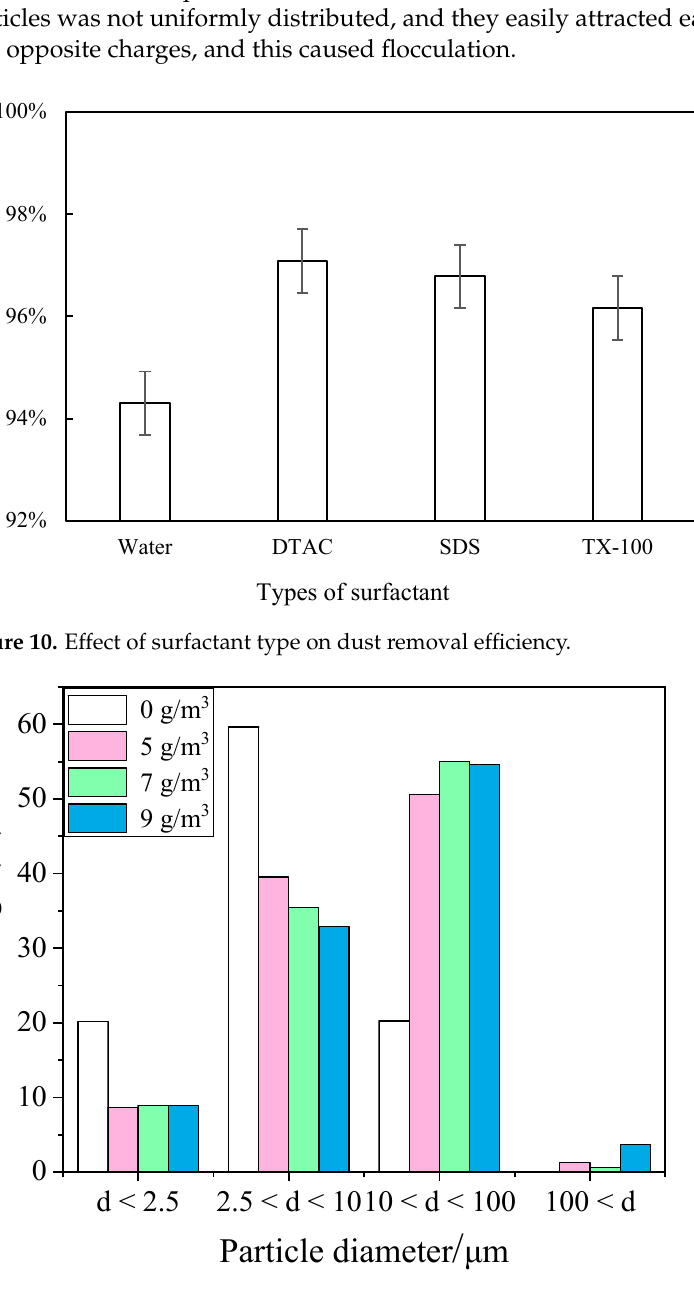
Figure 11. Histogram of particle size interval content of surfactant concentration.